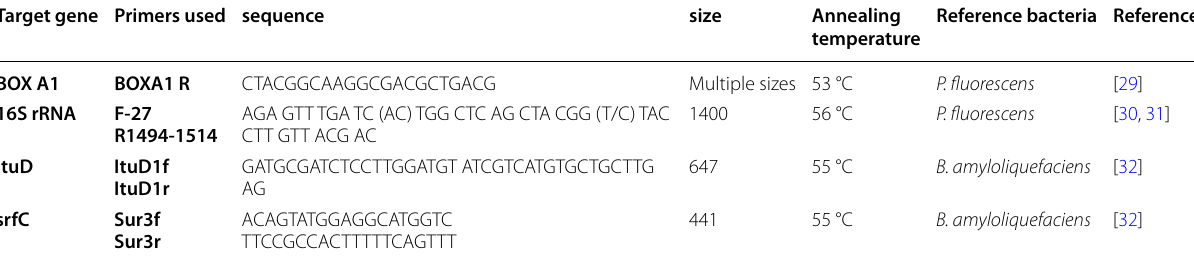
Table 1 Primers used in this study Target gene Primers used